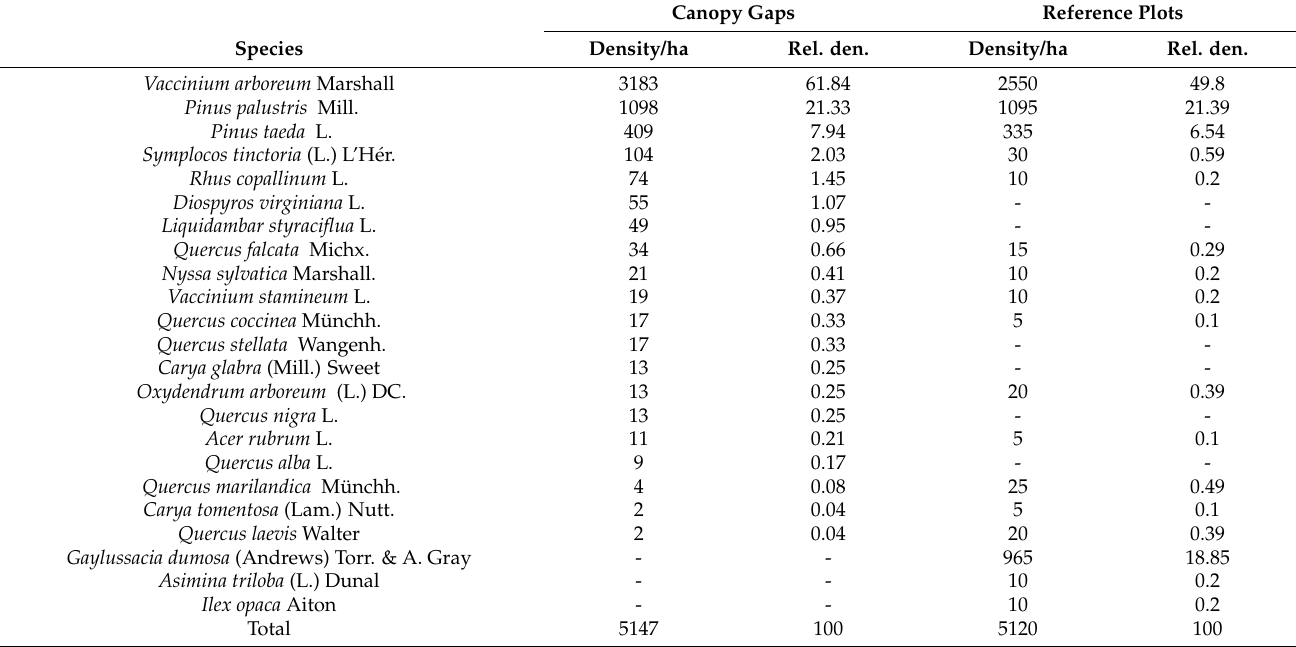
Table 3. Density and relative density for seedlings (woody stems < 1 m tall) in canopy gap and reference (non-gap) plots in a montane Pinus palustris